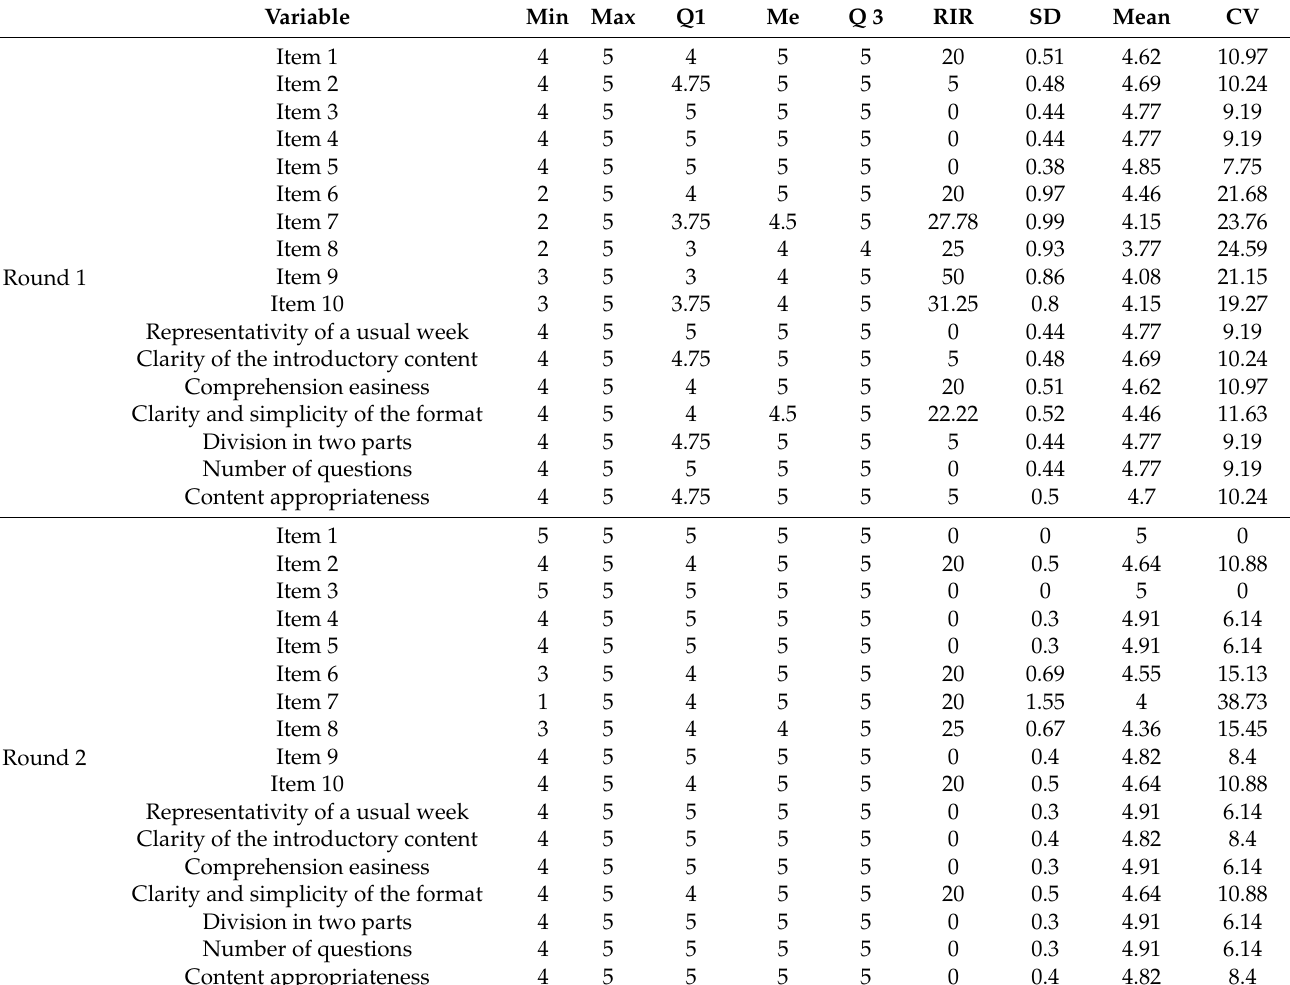
Table 3. Degree of the agreement for each of the items and general characteristics in the consulting